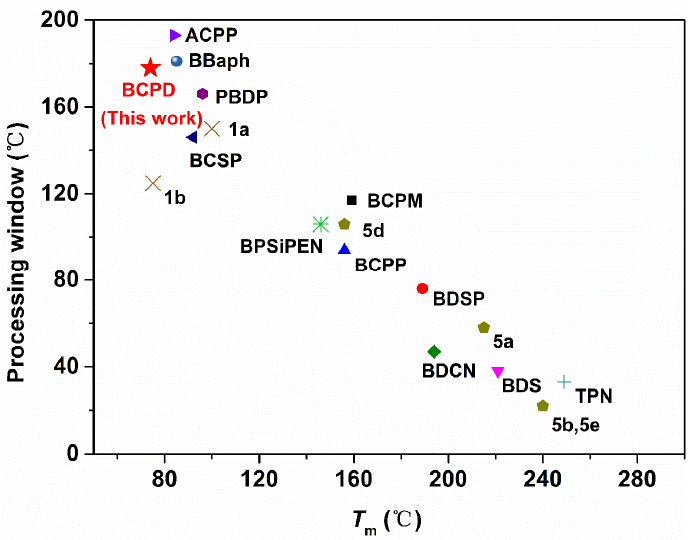
Figure 5. The processing performance of phthalonitrile in this work is compared with that reported in the literature [3,4,11,12,20–28].